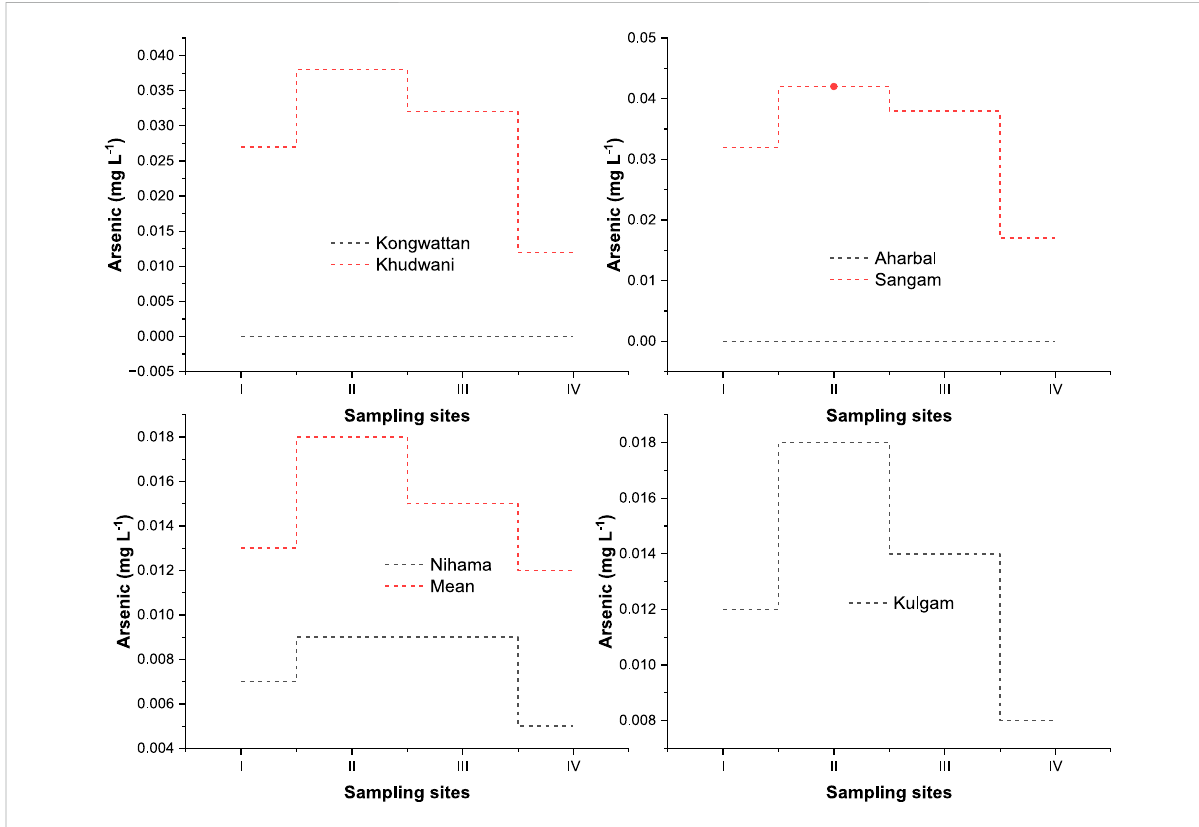
FIGURE 5 Figure depicting the comparative time-series seasonal variation analysis of Arsenic (As) in the water of the River Veshaw at six different sites collected during all the seasons from spring to winter (I:spring; II:summer; III:autumn; IV:winter; V) Each symbol represents the mean of triplicate